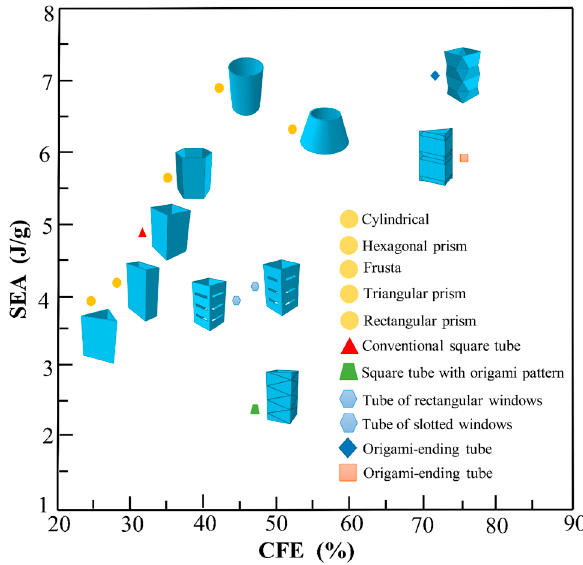
Figure 1. Comparison of SEA and CFE values of different structures.